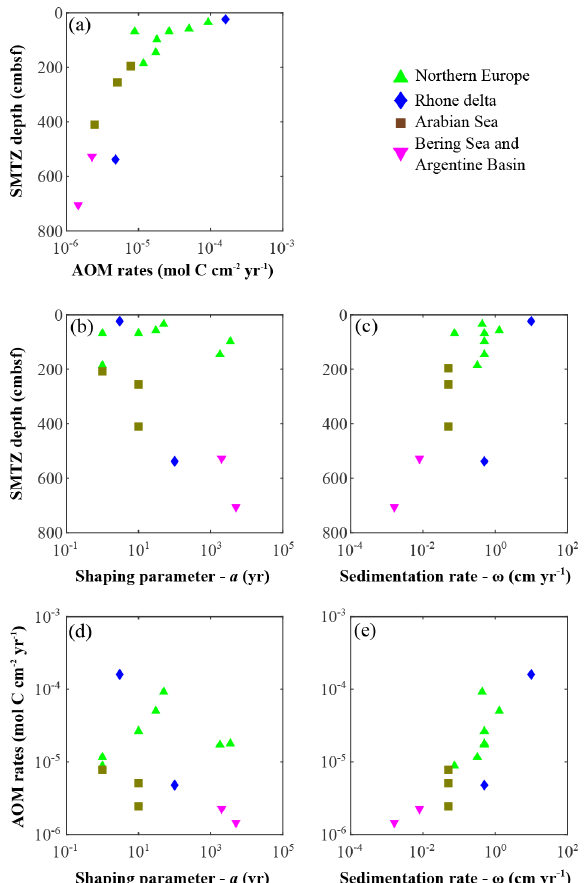
Figure 8. Anaerobic oxidation of methane (AOM) patterns as a function of apparent organic matter reactivity and depositional rates. (a) AOM rates vs. SMTZ depth; SMTZ depths vs. (b) reactiv- ity parameter a and (c) sedimentation rates ω ; AOM rates vs. (d) re- activity parameter a and (e) sedimentation rates ω